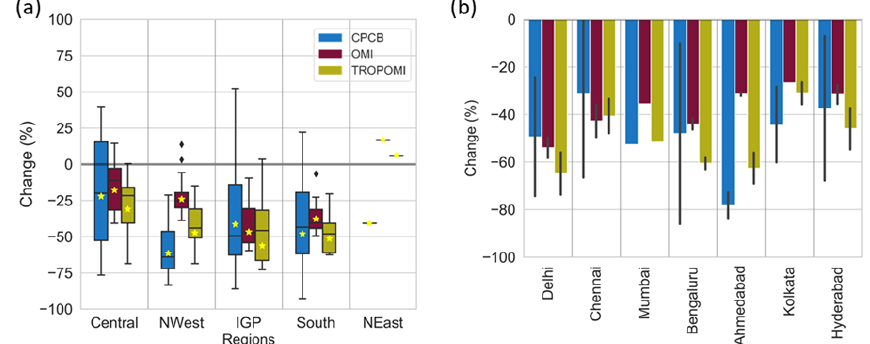
Figure 8. (a) Box plot showing the percentage change between LDN and BAU in NO 2 levels observed by ground and satellite measurements at CPCB monitoring locations in different regions. (b) Bar chart showing the percentage change in NO 2 levels observed in megacities in India for the same measurements as panel (a) . The vertical line in the bar chart is the standard